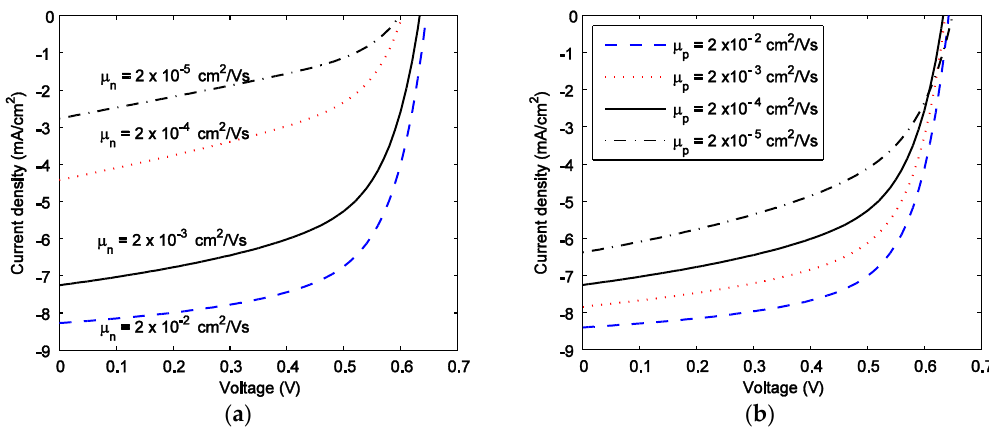
Figure 9. Theoretical current-voltage characteristics of P3HT:PCBM solar cells for ( a ) varying electron mobility with µ p = 2 × 10 −4 cm 2 /Vs and ( b ) varying hole mobility with µ n = 2 × 10 −3 cm 2 /Vs. Carrier mobility with µ p = 2 ˆ 10 ´ 4 cm 2 /Vs and ( b ) varying hole mobility with µ n = 2 ˆ 10 ´ 3 cm 2 /Vs. Carrier lifetimes are:  n =  p = 20  s. lifetimes are: τ n = τ p = 20 µ s.